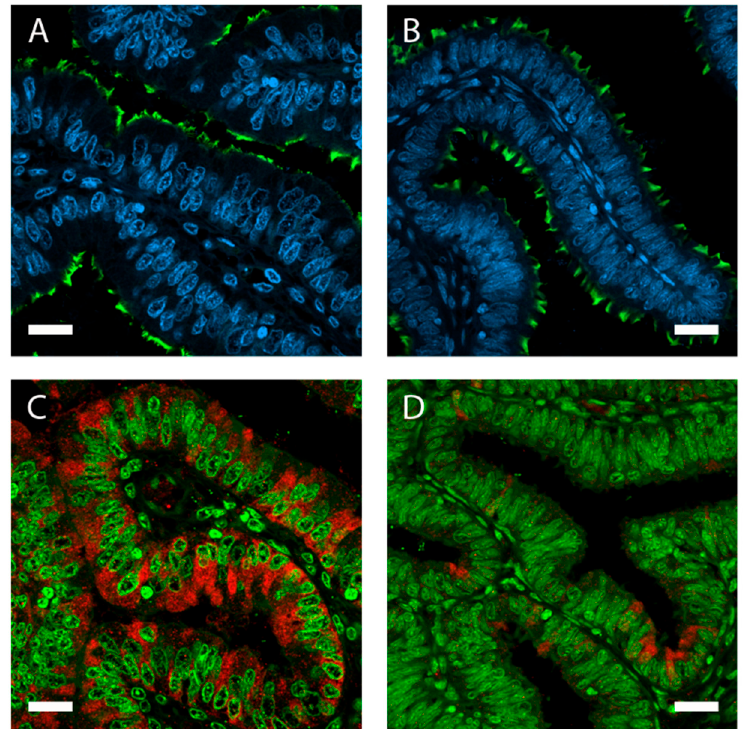
Figure 2. The oviduct lumen is lined by a simple, columnar-shaped epithelium containing non-ciliated and ciliated cells. Immunolocalization of acetylated tubulin ( A , B ; green) in porcine oviduct epithelium visualizes motile cilia bordering the lumen. Epithelial height, cell volume, and protein expression is influenced by estrous cycle stages. Oviduct tissue from the ampulla in ( A ) follicular and ( B ) luteal phase. Higher expression of oviductin (oviduct-specific glycoprotein 1 (OVGP1); red) in follicular ( C ) compared with luteal ( D ) phase. Nuclei stained with 4 ′ ,6-diamidino-2-phénylindole (DAPI) ( A , B ; blue) and SYBR Green ( C , D ; green). Magnification 400×, scale bars: 20 µm.